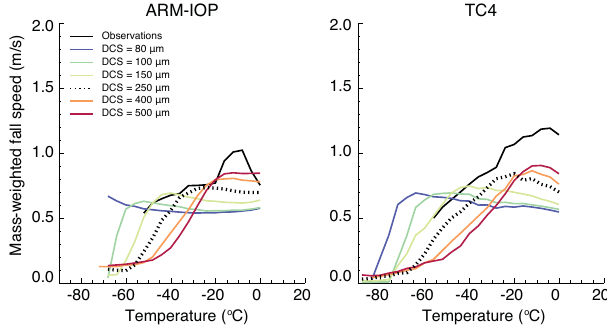
Figure 12. Same as Figs. 7 and 8, but using different D cs